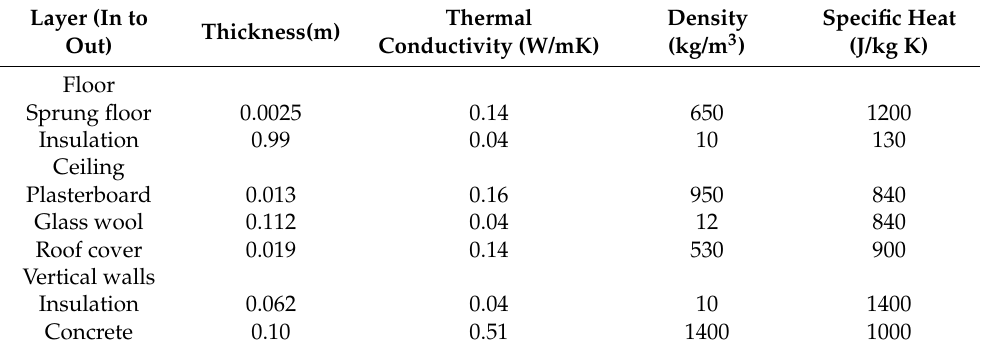
Table 1. Composition of the building envelope; ceiling and floor are the same in both cases and for walls, concrete is outside for the envelope with a light thermal mass and inside for the heavy